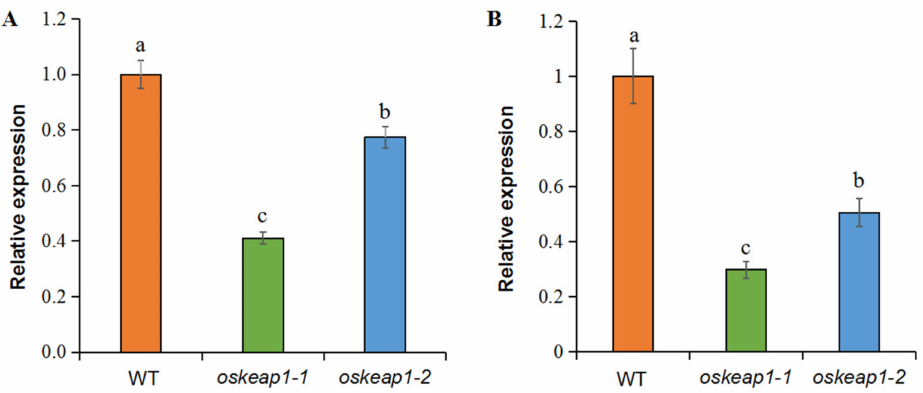
Figure 4. Relative expression of OsKEAP1 in leaf tissues at seedling ( A ) and heading stage ( B ) of rice cultivar Xidao #1 (WT) and its two oskeap1 mutants. The expression levels of the two mutants are compared with their wild-type at the same stage. OsACTIN was used as an internal reference. Data are shown in mean ± standard error of 3 biological repeats. Di ff erent letters (a,b,c) represent significant di ff erence at the 0.05